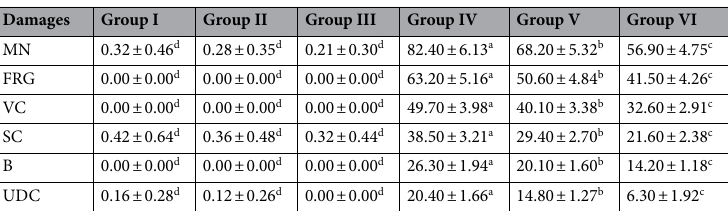
Table 2. Protective role of sage against uranyl acetate-induced genotoxicity. Group I: Control, Group II: 190 mg/L sage, Group III: 380 mg/L sage, Group IV: 0.1 mg/mL uranyl acetate, Group V: 0.1 mg/mL uranyl acetate + 190 mg/L sage, Group VI: 0.1 mg/mL uranyl acetate + 380 mg/L sage. Data are shown as mean ± SD (n = 10). MN and CAs were calculated by counting 1000 cells in each group. The averages shown with different letters (a–d) in the same line are important at p < 0.05. MN micronucleus, FRG fragment, VC vagrant chromosome, SC sticky chromosome, B bridge, UDC unequal distribution of